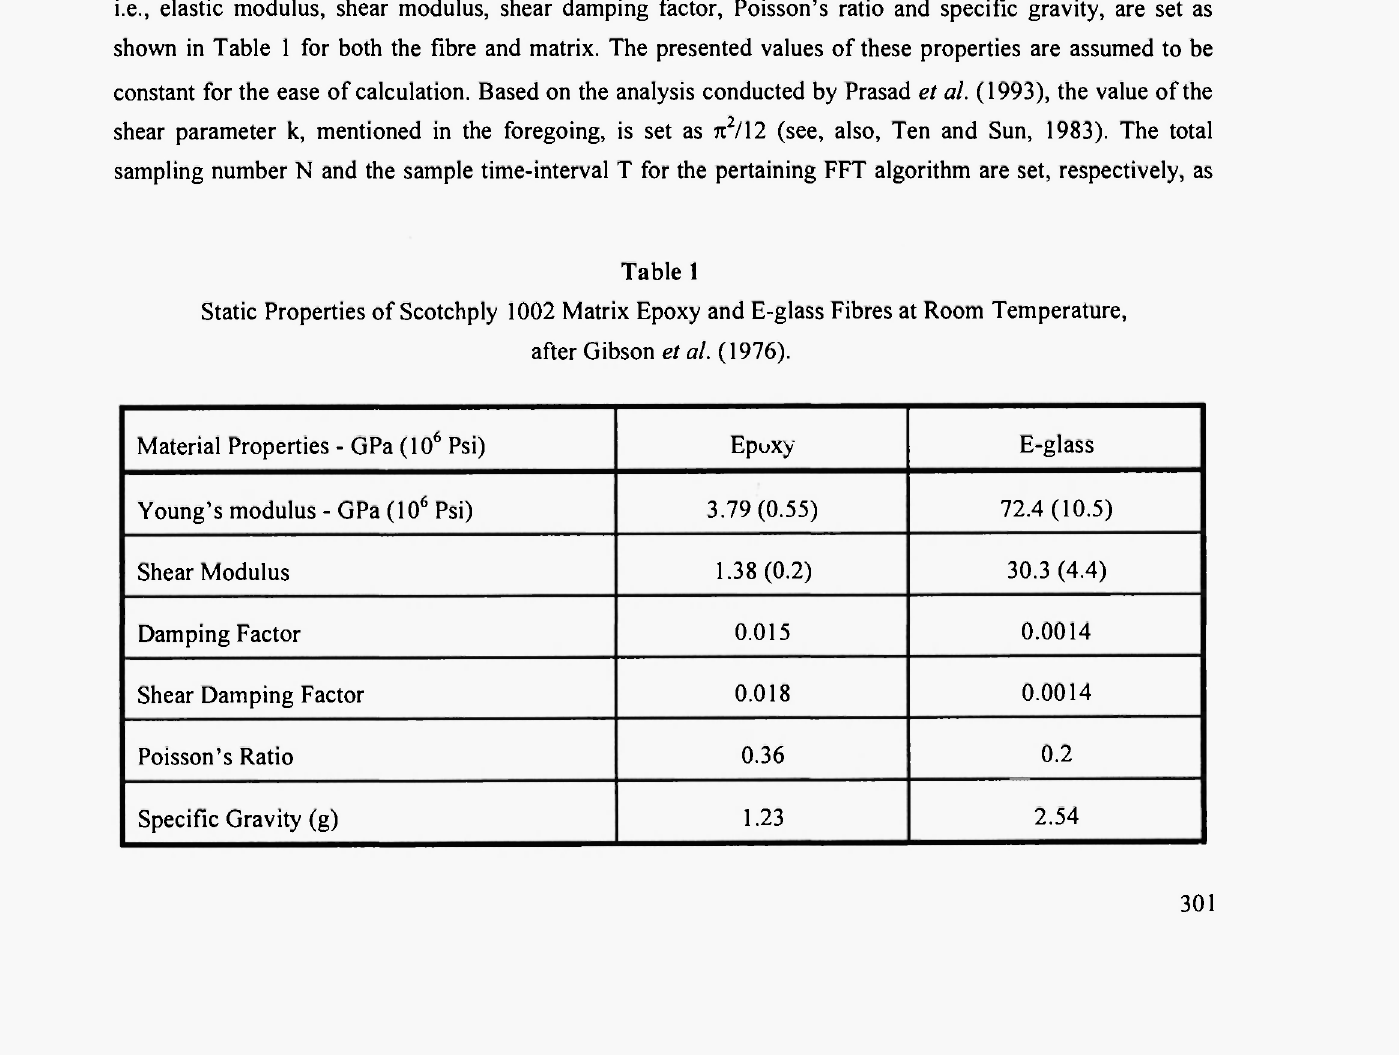
Static Properties of Scotchply 1002 Matrix Epoxy and Ε-glass Fibres at Room Temperature, after Gibson et al.